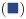
Development of preliminary screens to assess e-liquid toxicity in vitro.Cells were incubated for 8 h in 384-well plates, e-liquids were added as indicated for 24 h, and bright-field images were automatically obtained every 2 h to determine growth rates. Cell surface area, as an indicator of confluency, was normalized to the media control. All N = 4. (A) Bright-field images of HEK293T cells incubated overnight with vehicle, 10% PG/VG + media, or 1% banana pudding-, candy corn-, chocolate fudge-, or popcorn-flavored e-liquids. (B) Mean representative growth curves obtained from the bright-field images over time. Curves were categorized as follows: normal growth, media control (■) and popcorn (Δ); reduced growth, candy corn (▲); no growth, banana pudding (♦); and toxic, 10% PG/VG (●) and chocolate fudge (○). (C) Images of HEK293T cells stained with calcein-AM after overnight incubation with vehicle, 10% PG/VG + media, 1% banana pudding-, candy corn-, chocolate fudge-, or popcorn-flavored e-liquids. (D) Quantification of calcein-AM fluorescence (i.e., viability) expressed as mean ± SEM. All n = 3. The positive control (10% PG/VG + media) used the same PG/VG ratio as the e-liquids. (E) Heat map depicting Δ growth (%) and live-cell fluorescence (%). Growth control and PG/VG controls are shown for reference. E-liquids are grouped in 3 distinct categories from the clustering: 1 (red), e-liquids that showed low Δ growth and live-cell fluorescence % (0%–40%); 2 (yellow), e-liquids that showed moderate (40%–100%) Δ growth and low live-cell fluorescence % (0%–40%); and 3 (green), e-liquids that showed high Δ growth and live-cell fluorescence % (80%–100%). (F) E-liquids were grouped according to Δ growth and live-cell fluorescence. Numbers represent number of e-liquids in a category. Raw data are available in S1 Data. HEK293T, human embryonic kidney 293 cells; PG, propylene glycol; VG, vegetable glycerin.